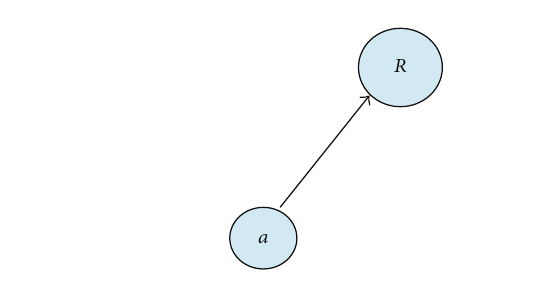
Figure 12: Node 𝑎 has only one path to the root. Table 3: Parameter values for the WPA algorithm.